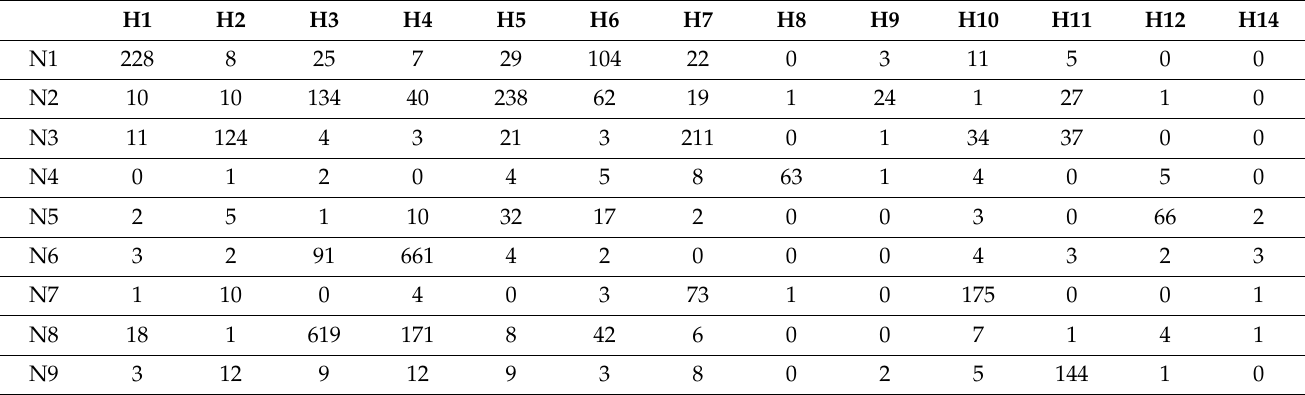
Table 4. Number of AIV strains with different combinations of HAs and NAs isolated from wild birds of the order Anseriformes in the United States in 1990–2021. Influenza Research Database (https://legacy.fludb.org, accessed on 20 October